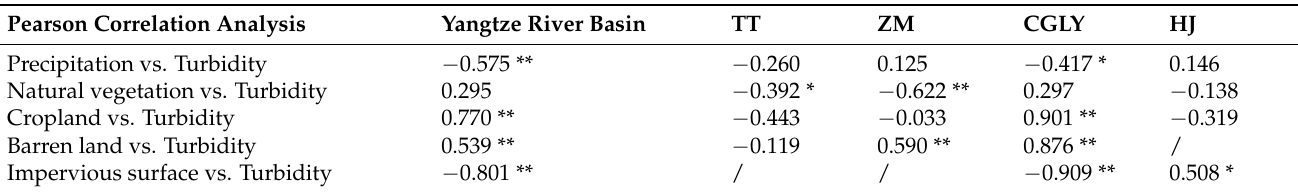
Table 3. Pearson correlation was used to analyze the influence of interpretive factors on the spatial variation of turbidity in the Yangtze River